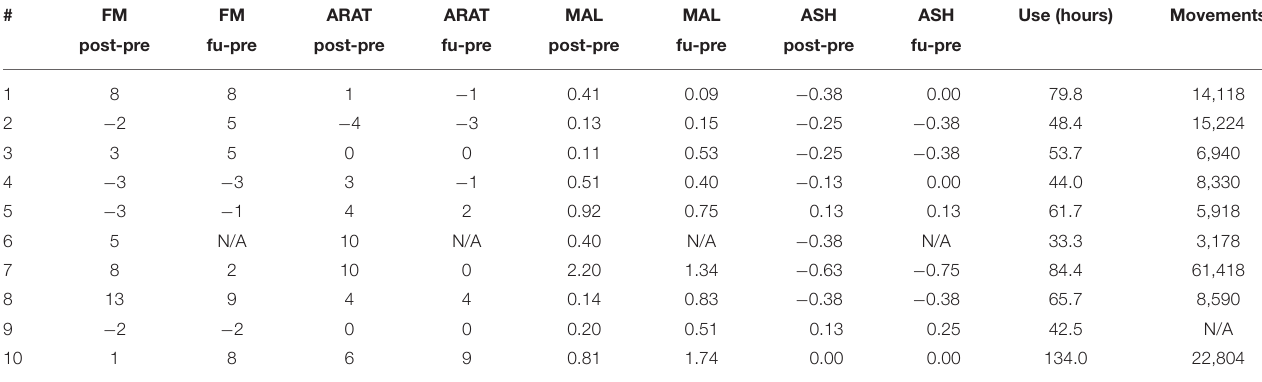
TABLE 3 | Individual gains in outcome